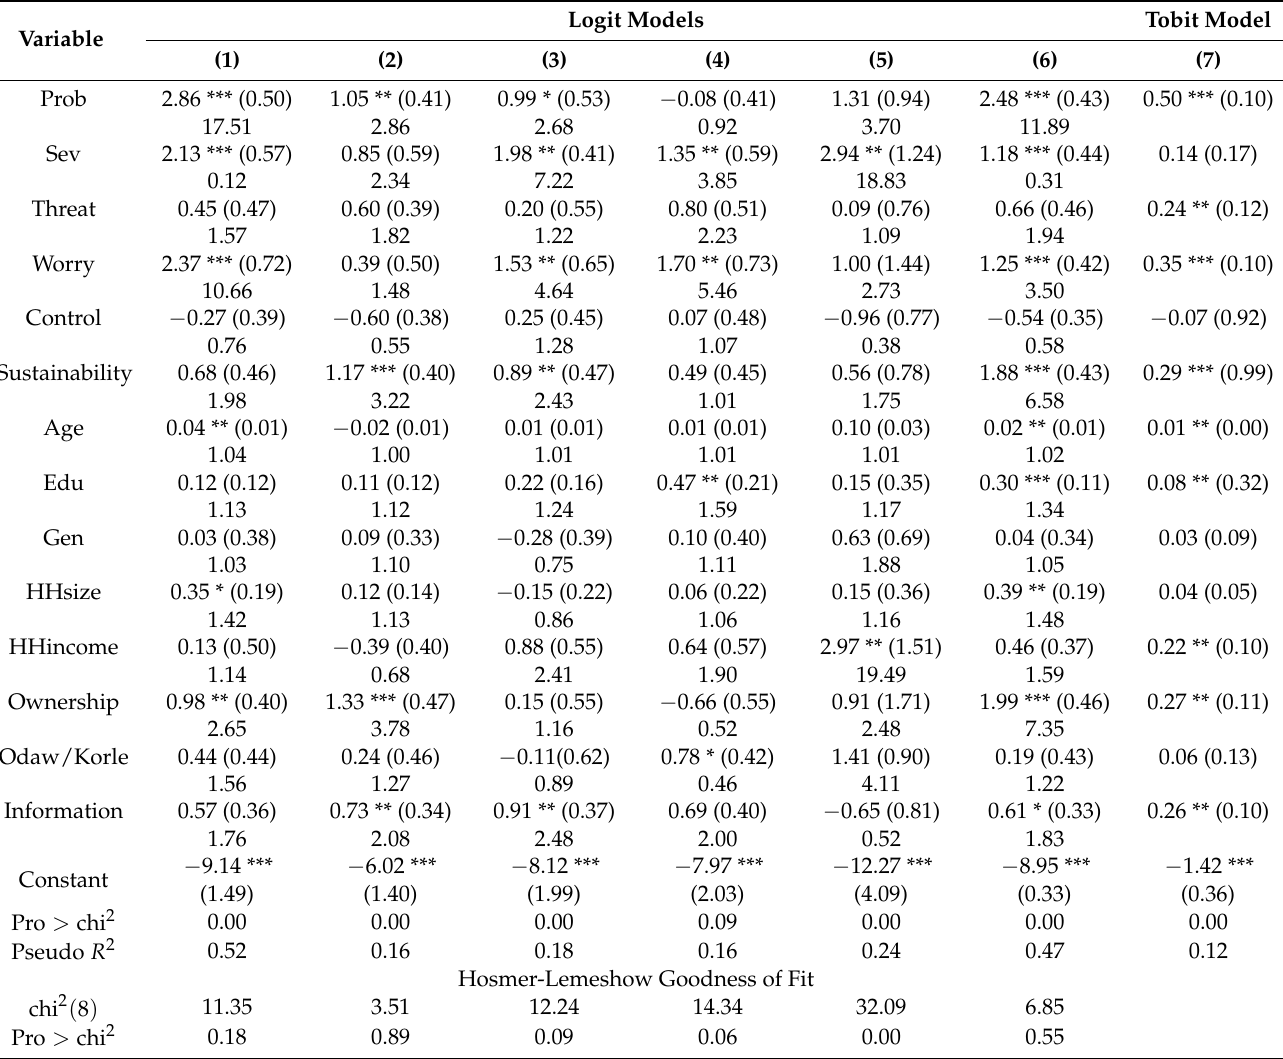
Table 6. Household’s adoption of FDP behaviours—regression